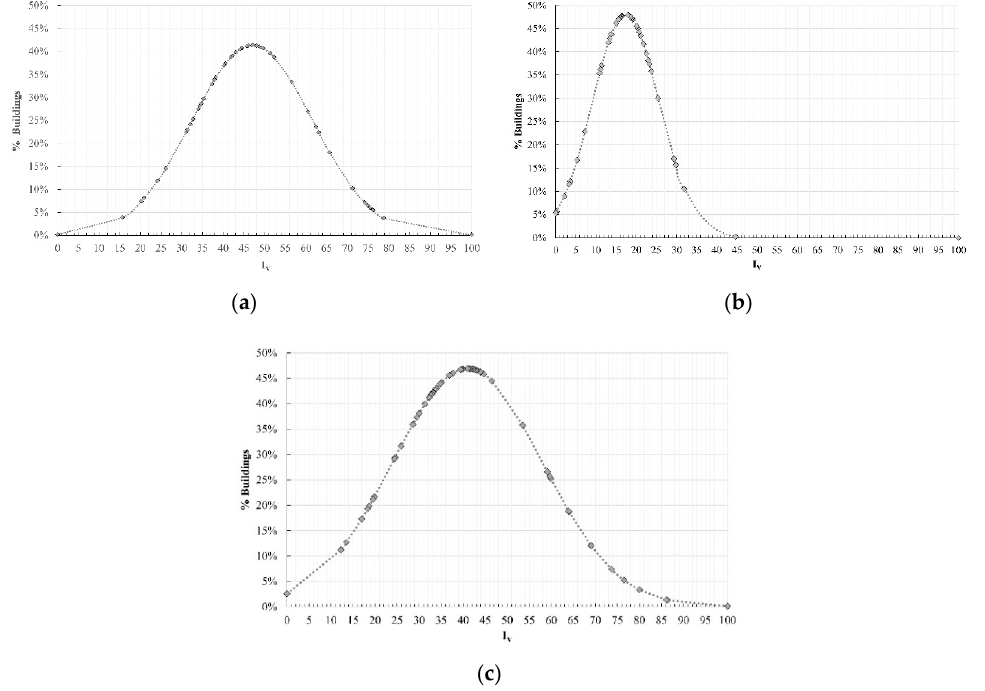
Figure 9. I V distribution in the case study according to ( a ) the GDNT method, ( b ) the Formisano method and ( c ) the Vicente method.